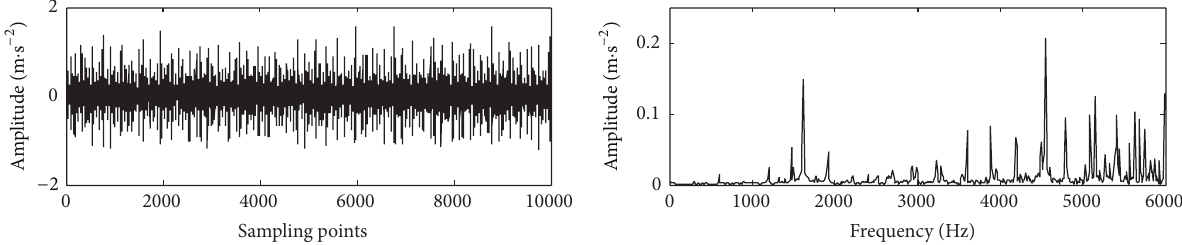
Figure 7: The bearing fault signal and its spectrum.